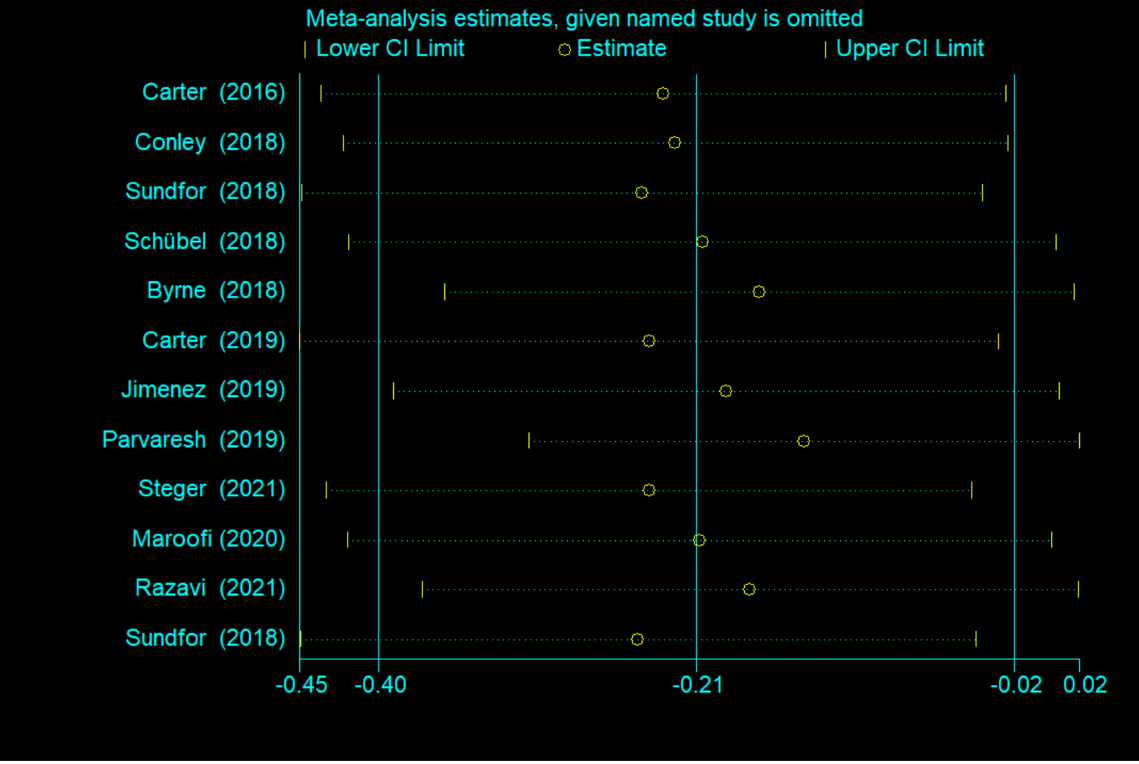
Figure 14. Impact analysis of a single study based on body